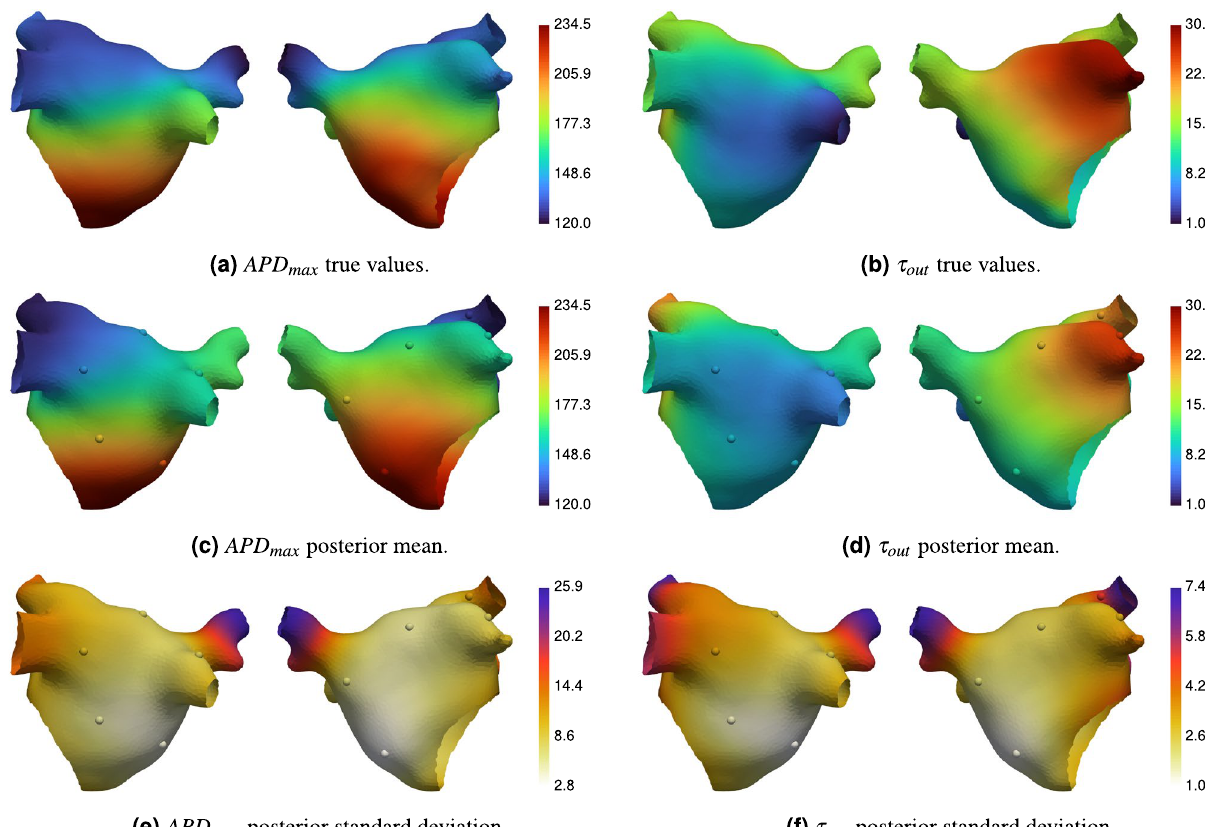
Figure 3. Ground truth and predicted (posterior mean and standard deviation) electrophysiology parameter fields. The spheres show the location of ERP measurements. All units are